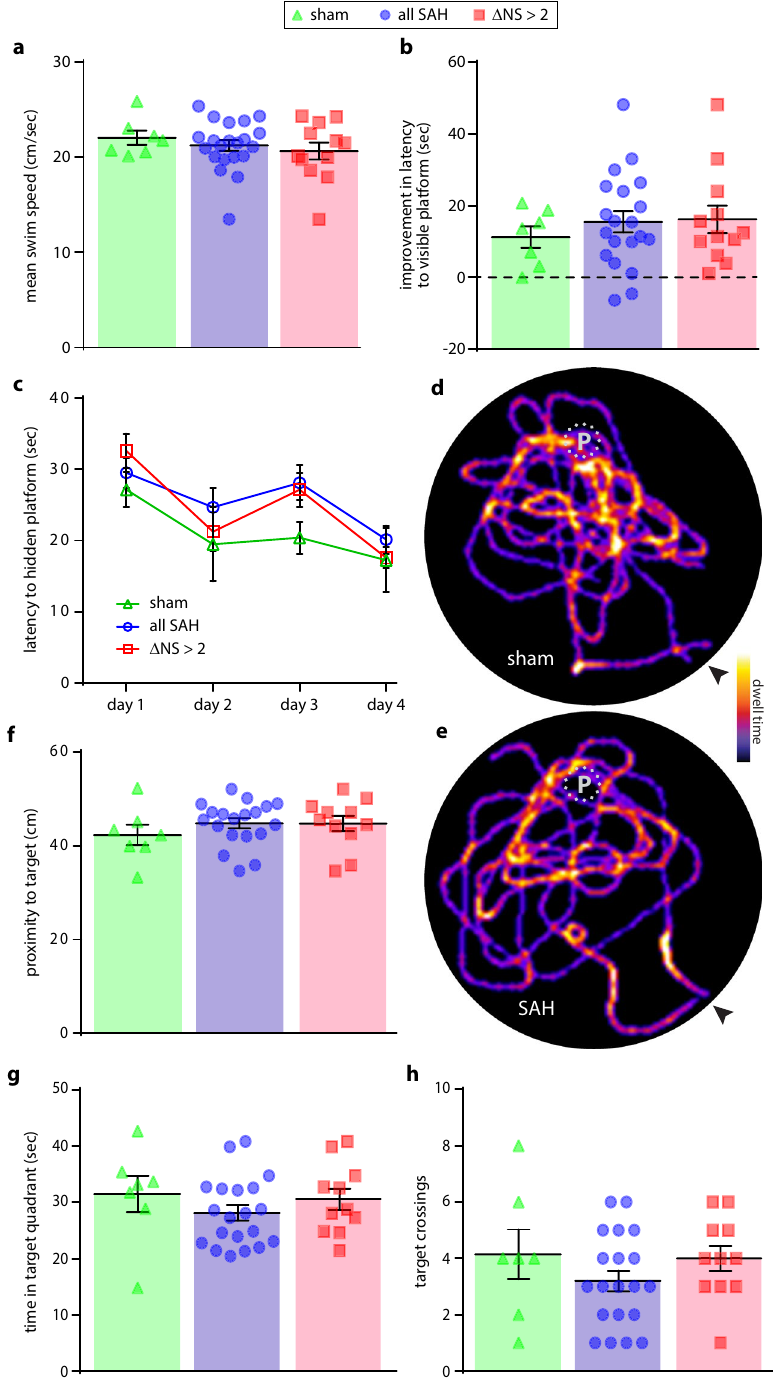
Figure 5. Learning and memory. Measurement of mean swim speed in the Morris water maze visible platform test ( a ). Improvement in time to reach a visible platform was quantified during cued training over 3 days ( b ). Performance over 4 days of hidden platform training was monitored ( c ), followed by a single probe test in which the platform was removed and the swim pathways ( d , e ) two representative paths are show for each group; platform indicated with P; point of insertion indicated with arrowhead), average distance from the target ( f ), time in the quadrant of the pool containing the target platform ( g ), and number of platform crosses ( h ) were monitored and quantified. t-test with Holm-Bonferroni correction for multiple comparisons ( a , b , f – h ). 2-way repeated-measures ANOVA ( c